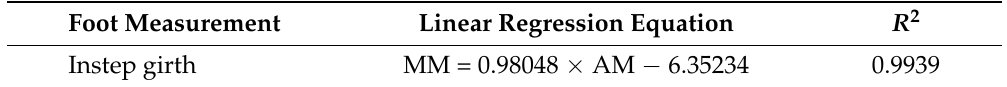
Figure 8. Linear regression between AM and MM for the instep girth of the training dataset. Table 5. Linear regression, MM = a × AM + b for the instep girth that had significant differences between AM and MM of the training dataset.